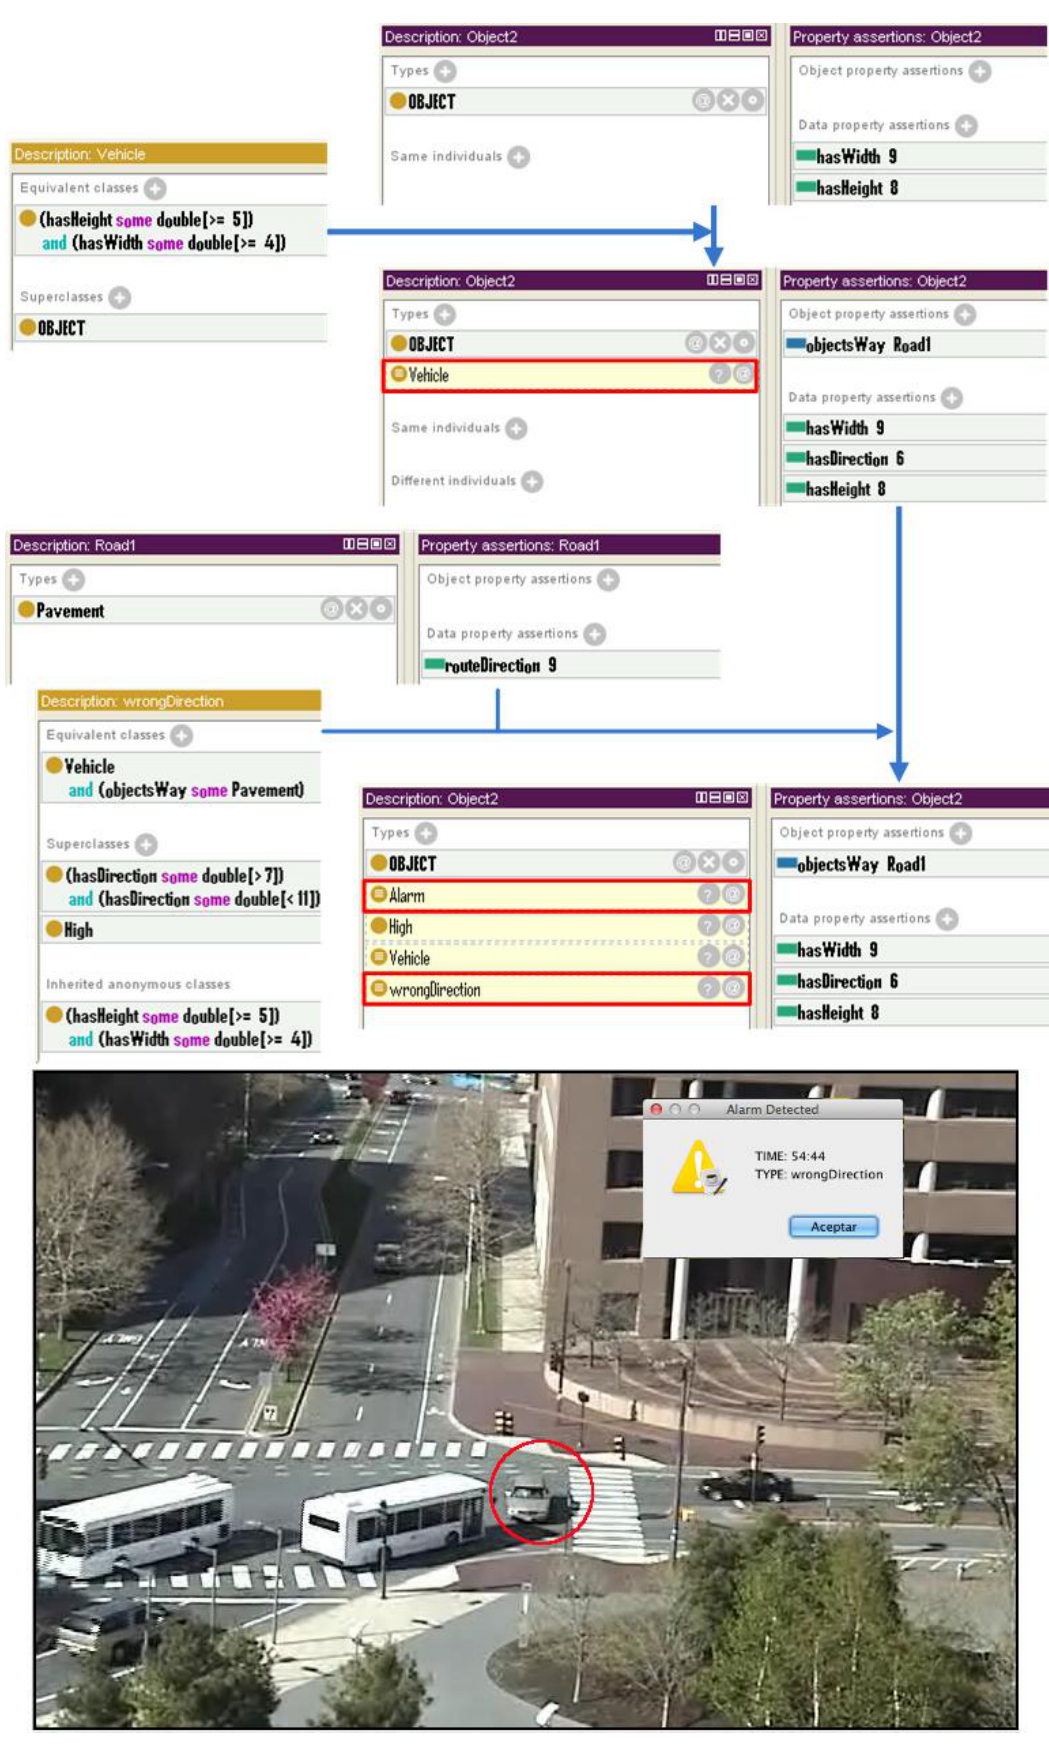
Figure 8. Example of semantic reasoning for vehicle use